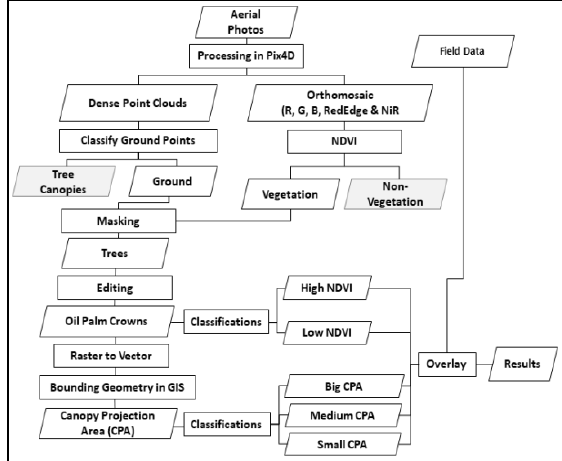
Figure 2. Workflow of the Study